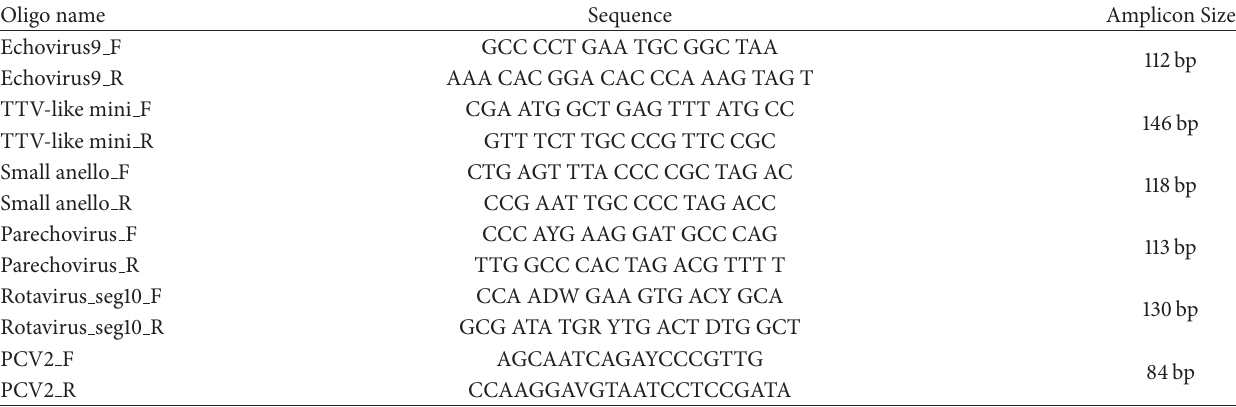
Table 2: PCR assay primer sequences and expected amplicon sizes. The primers for echovirus, TTV like minivirus, small anellovirus, parechovirus, and rotavirus A were designed by LLNL as part of this study. The primers for PCV-2 were obtained from McClenahan et al. [25].